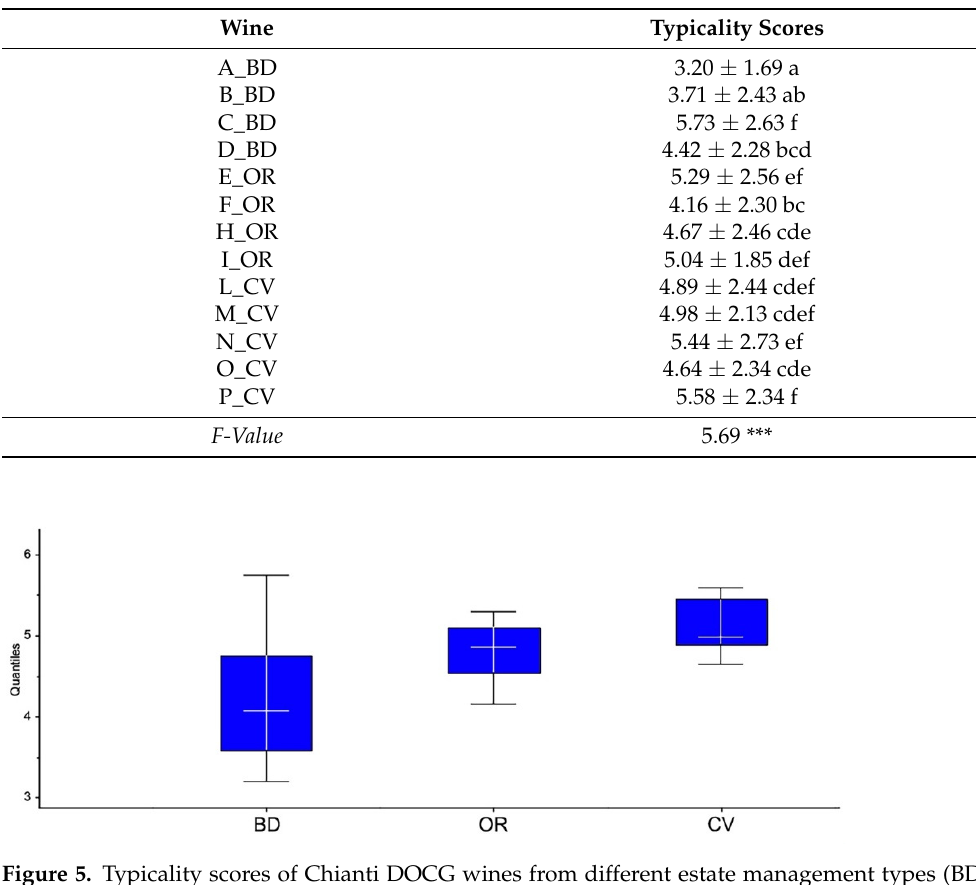
Table 6. Typicality scores of Chianti DOCG wines assigned by the expert panel (mean value, standard deviation, statistical groups, and F-value). Different letters (a–f) indicate statistically significant differences (***: p -value < 0.001).